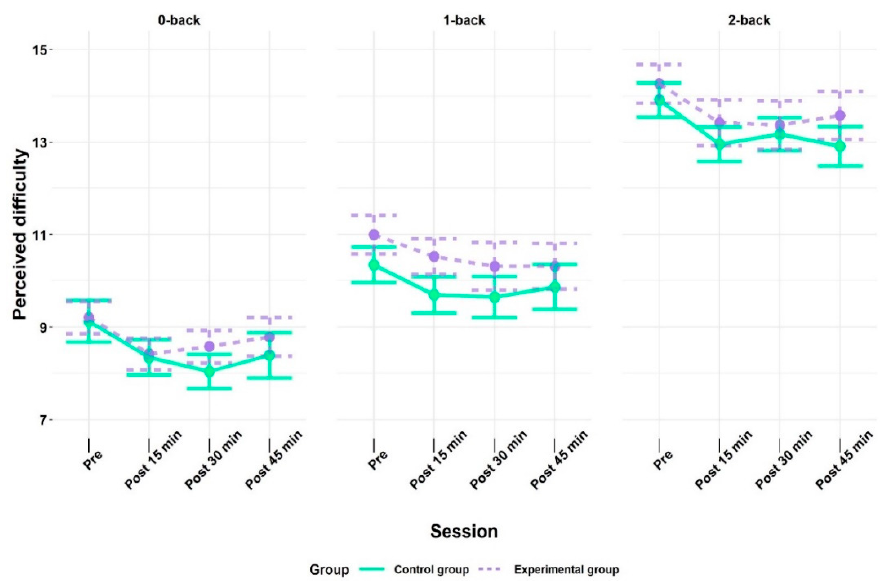
Figure 5. Perceived difficulty of the n-back task indicated by the experimental (EG) and control group (CG) at time point pre (baseline) and at the follow-up measurements after the acute exercise intervention (EG) or listening to the audiobook (CG), respectively. All values are given as mean ( M ); error bars represent one standard error ( SE ) of the mean.